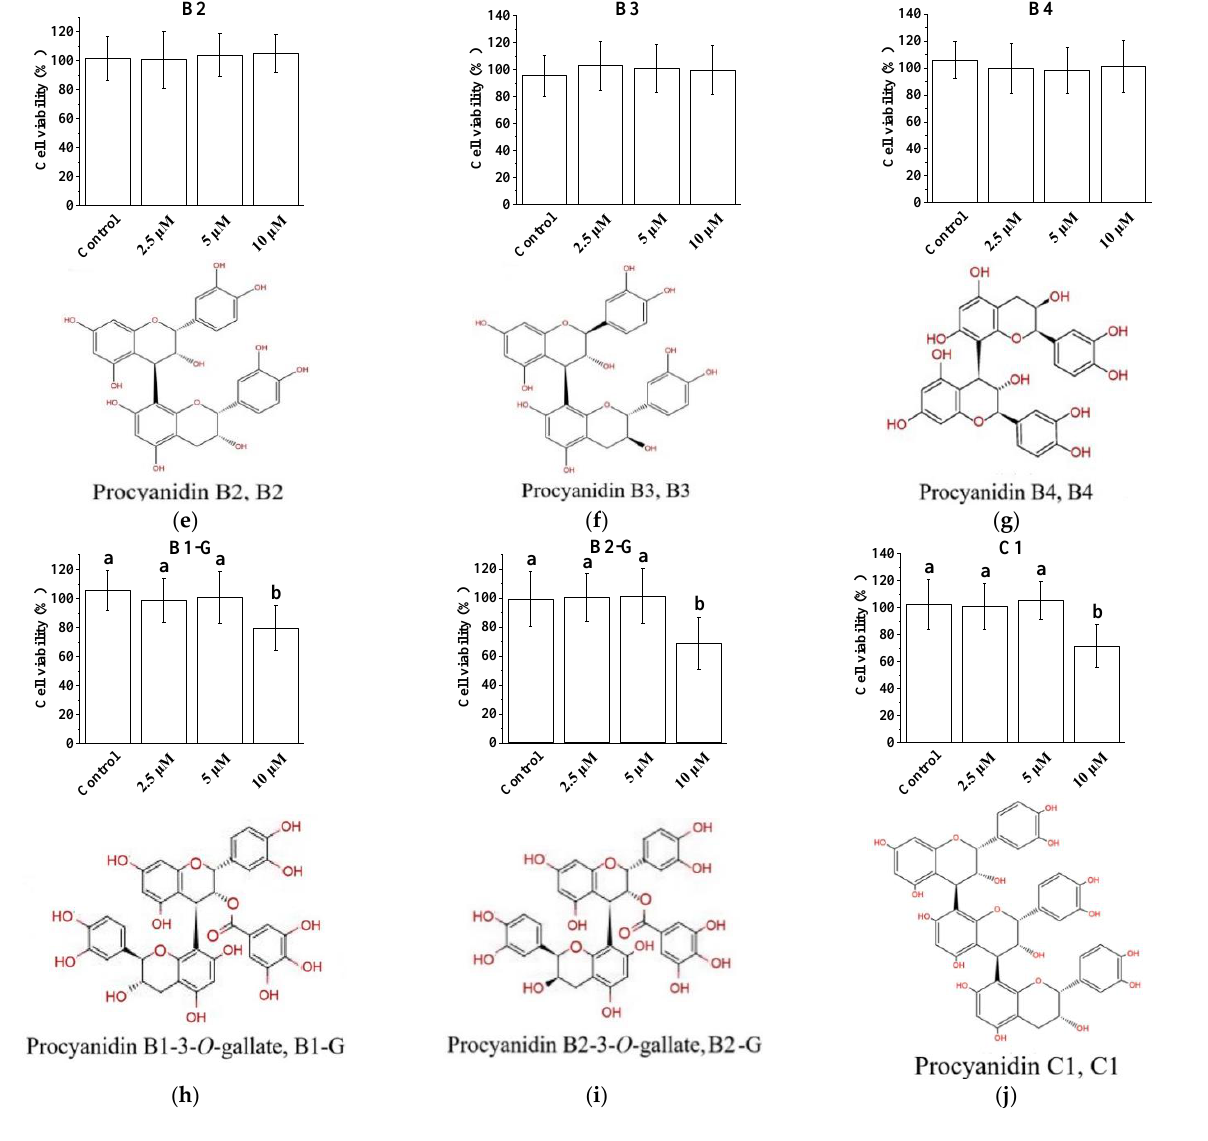
Figure 1. Cytotoxicity of different procyanidins in PC12 cells. ( a ) Survival of PC12 cells in the C treatment group; ( b ) Survival rate of PC12 cells in the EC treatment group; ( c ) Survival rate of PC12 cells in the ECG treatment group; ( d ) Survival rate of PC12 cells in the B1 treatment group; ( e ) Survival rate of PC12 cells in the B2 treatment group; ( f ) Survival rate of PC12 cells in the B3 treatment group; ( g ) Survival rate of PC12 cells in the B4 treatment group; ( h ) Survival rate of PC12 cells in the B1-G treatment group; ( i ) Survival rate of PC12 cells in the B2-G treatment group; ( j ) Survival rate of PC12 cells in the C1 treatment group. Data are expressed as the mean ± SD. All experiments were conducted six times. Values with different letters above each bar represent significant differences ( p < 0.05, one-way ANOVA). PC12, rat pheochromocytoma cell line; EC, epicatechin; ECG, epicatechin gallate; B1, procyanidin B1; B2, procyanidin B2; B3, procyanidin B3; B4, procyanidin B4; B1-G, procyanidin B1-3- O -gallate; B2-G: procyanidin B2-3- O -gallate; C1: procyanidin C1; SD, standard deviation; ANOVA, one-way analysis of variance.